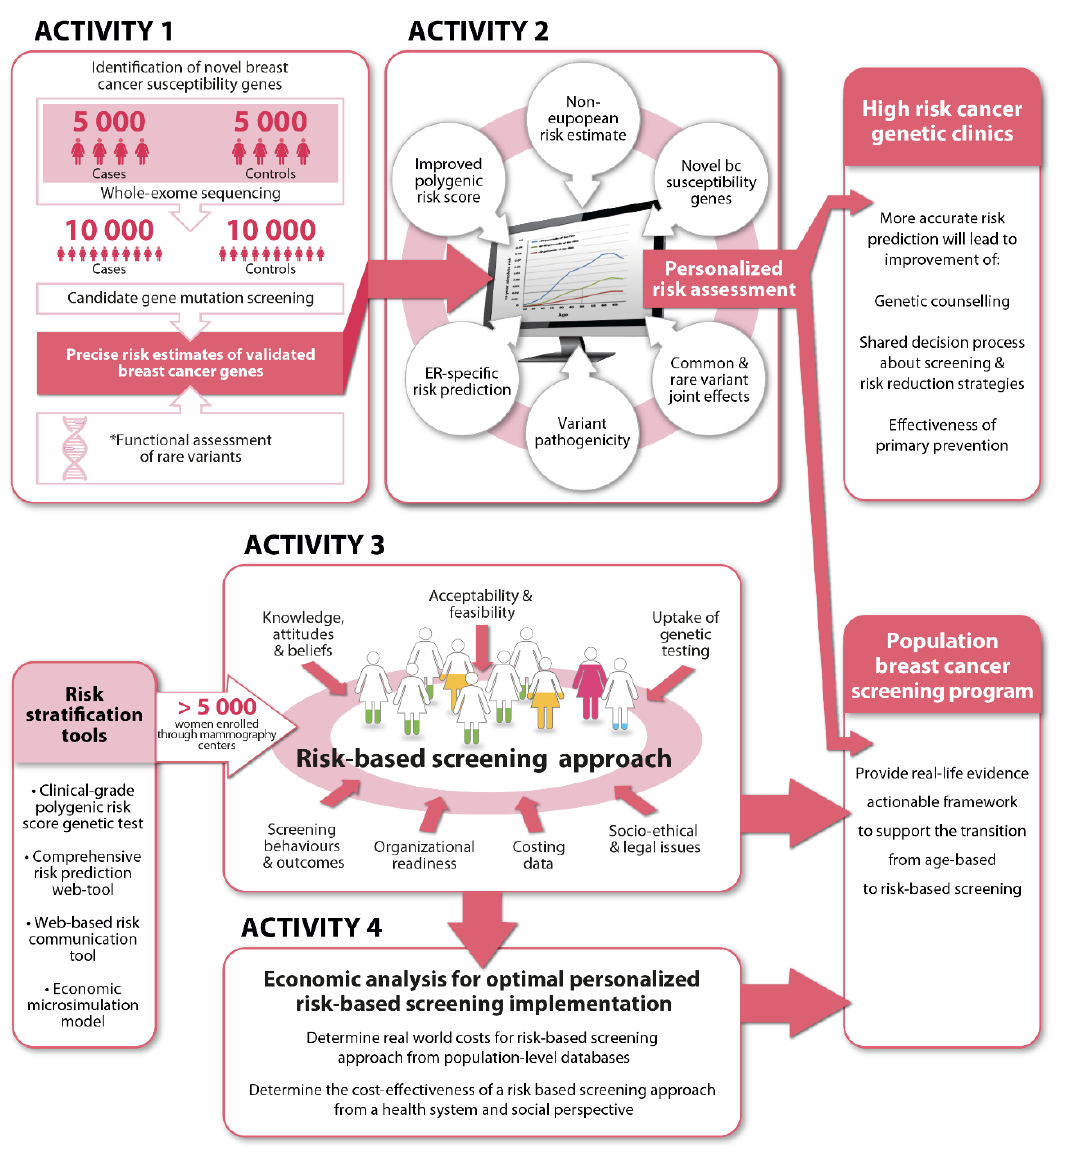
Figure 1. Overview of the PERSPECTIVE I&I project.